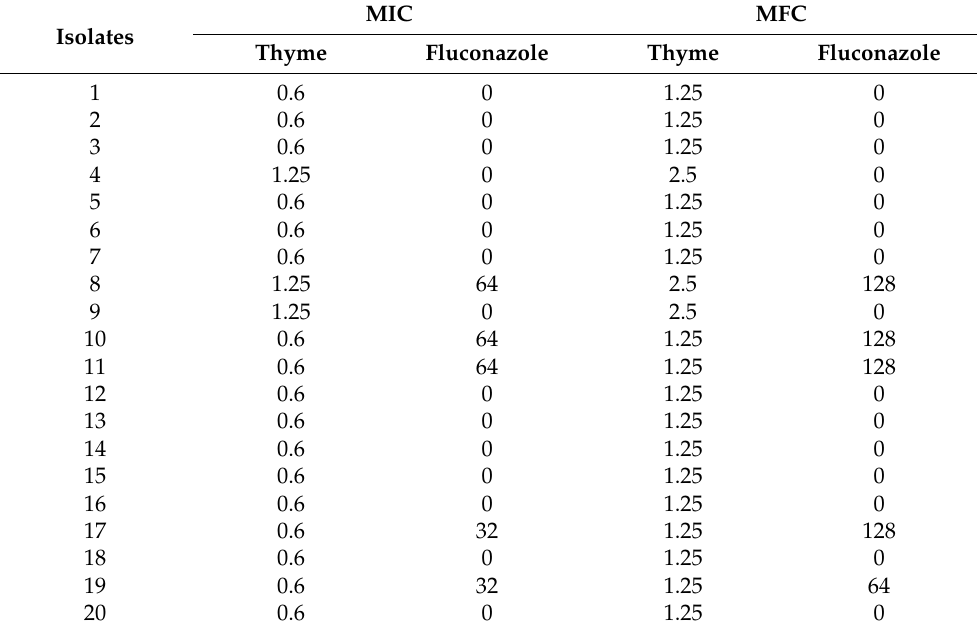
Table 5. Minimal Inhibitory Concentration (MIC) and Fungicidal Concentration (MFC) of the Thyme essential oil (TEO) against C. albicans . MIC MFC Isolates Thyme Fluconazole Thyme